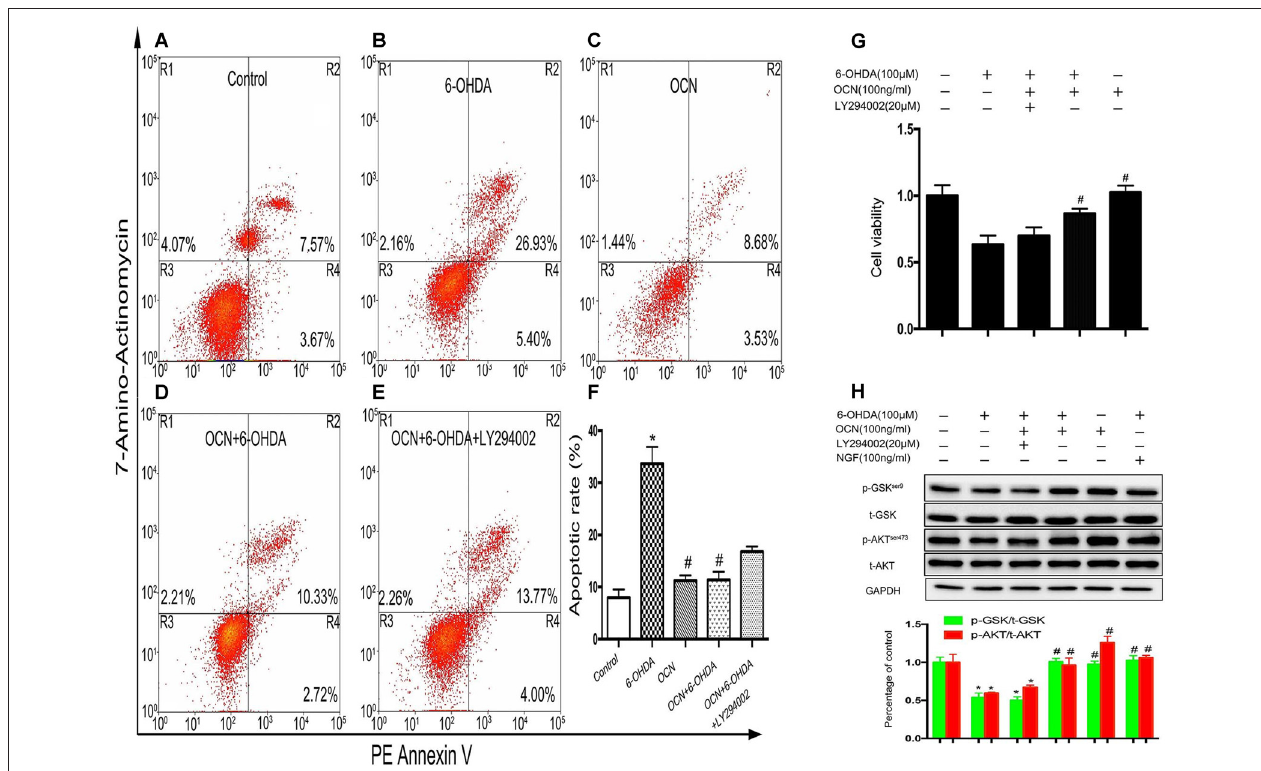
FIGURE 7 | OCN protects PC12 cells from 6-OHDA-induced neurotoxicity. Apoptotic cells were measured by flow cytometry (A–E) . The number of apoptotic cells was counted in the R2 (AV + /7-amino-actinomycin, 7-AAD + , the late phase apoptotic cells) and R4 (AV + /7-AAD − , the early phase apoptotic cells) regions, and the apoptotic rate was calculated (F) . The CCK-8 test showed that OCN could attenuate the neuronal toxicity induced by 6-OHDA through activating AKT/GSK3 β , while LY294002 reversed the neuroprotective effect of OCN on PC12 cells (G) through inhibiting the phosphorylation of AKT and GSK3 β (H) . Values were obtained from three independent experiments. ∗ P < 0.05 (compared with the control group), # P < 0.05 (compared with the 6-OHDA